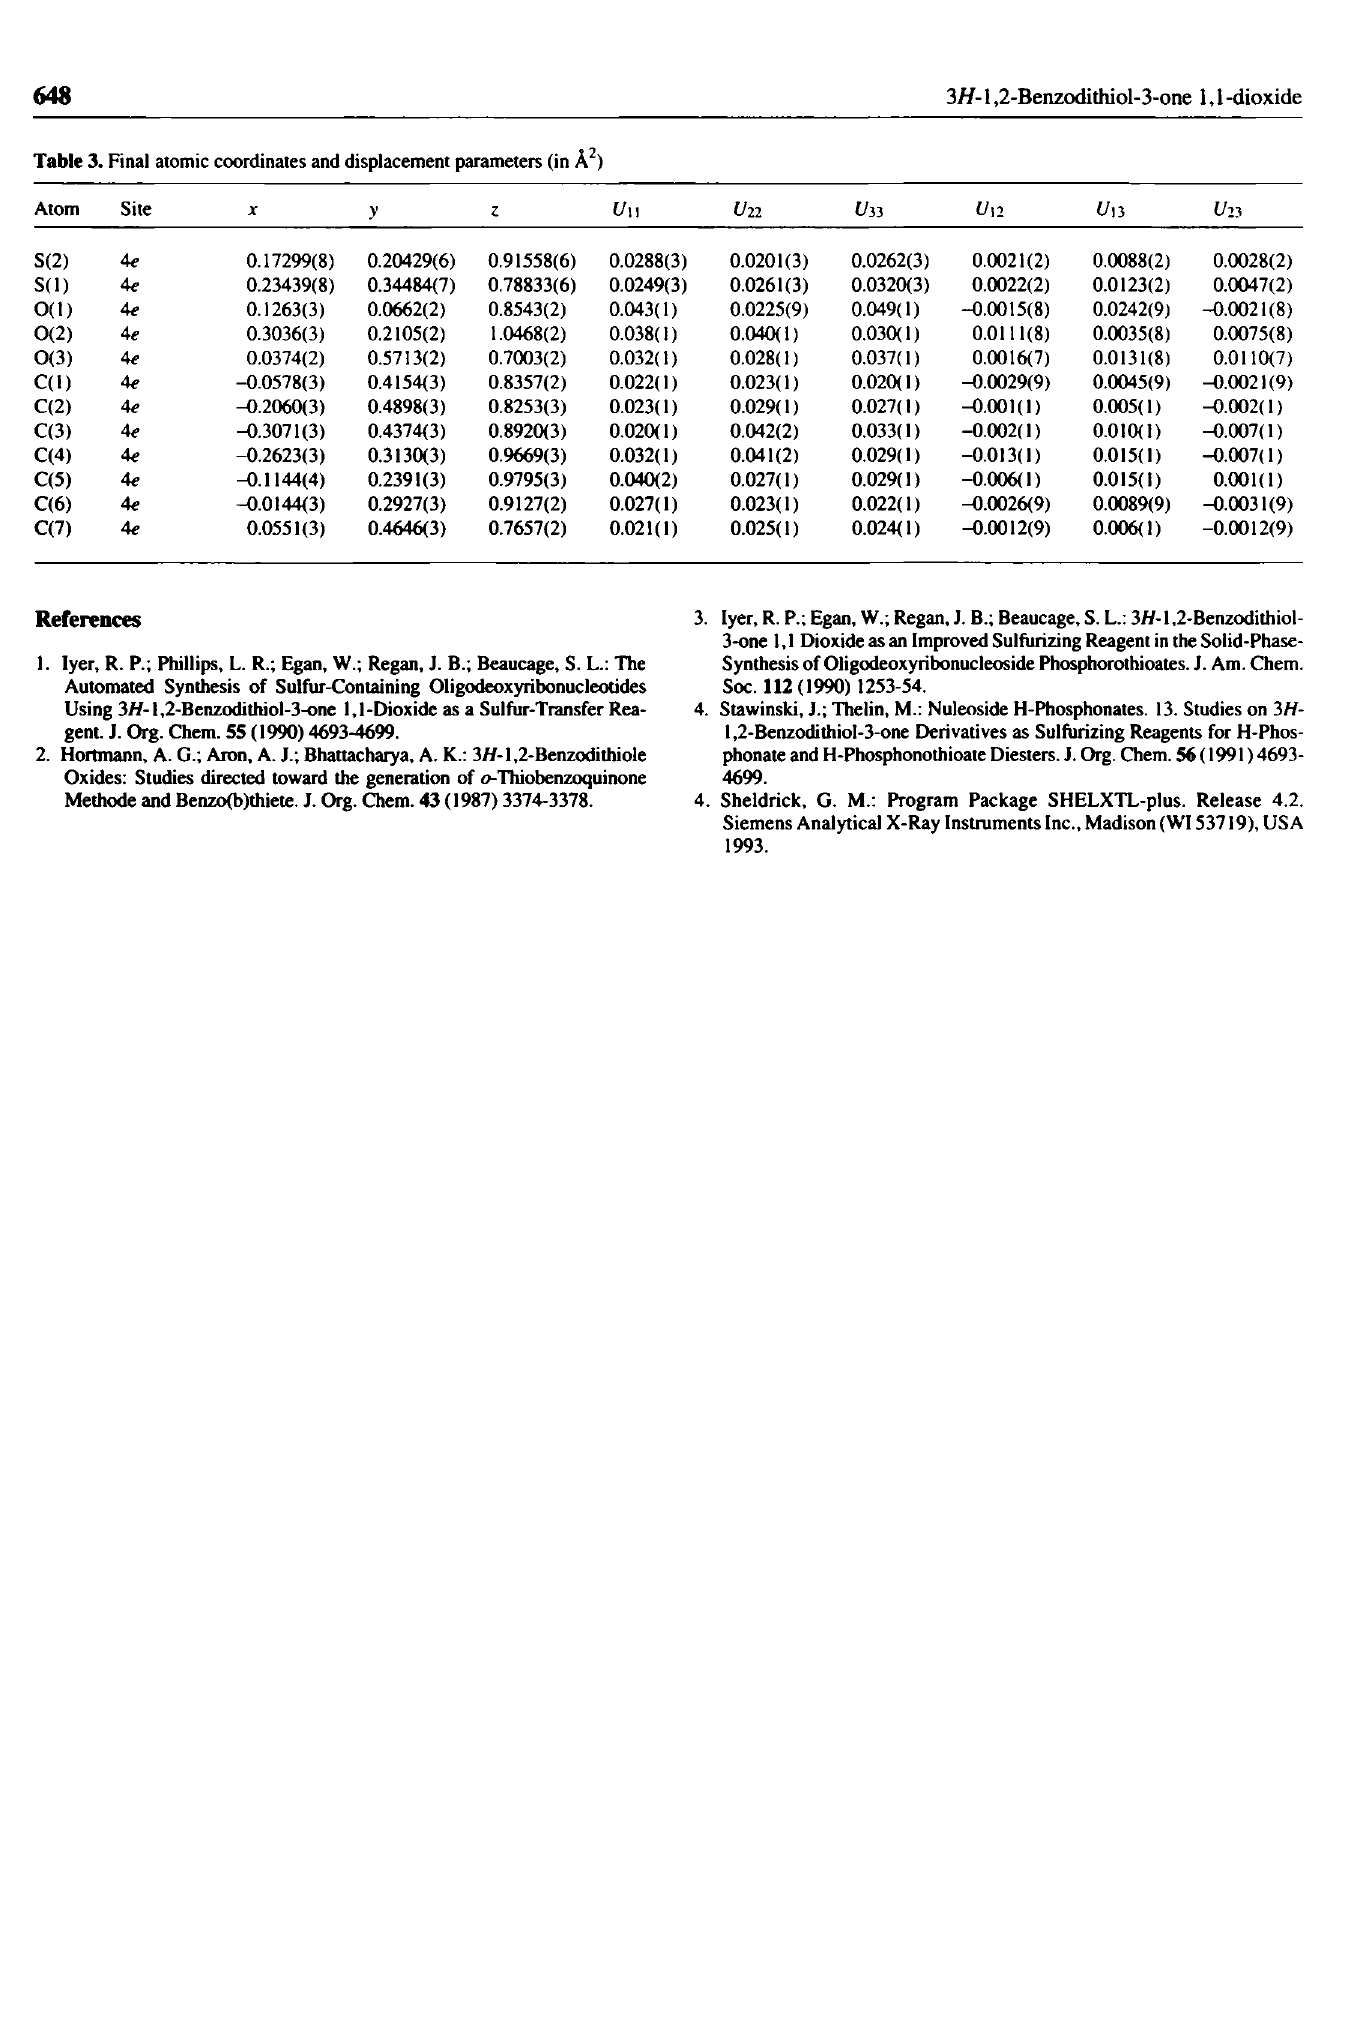
Table 3. Final atomic coordinates and displacement parameters (in